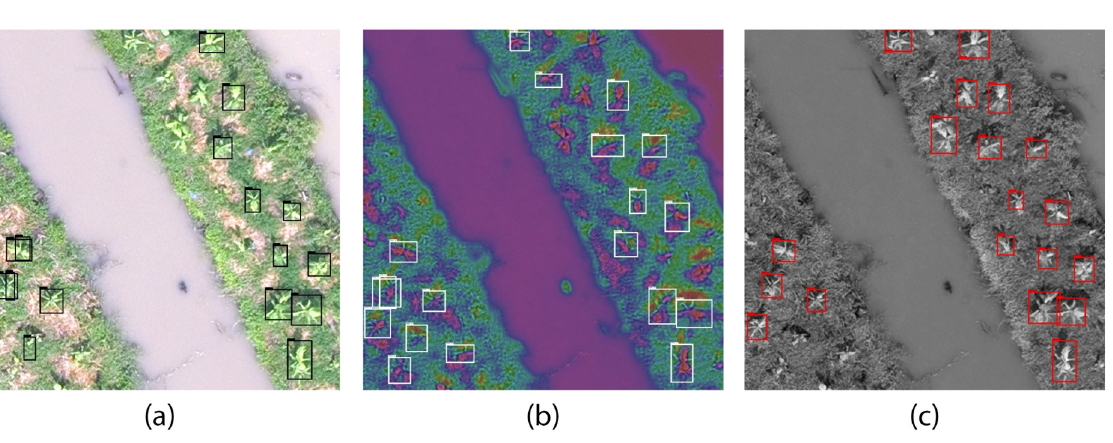
PLOS ONE | https://doi.org/10.1371/journal.pone.0223906 October 17,